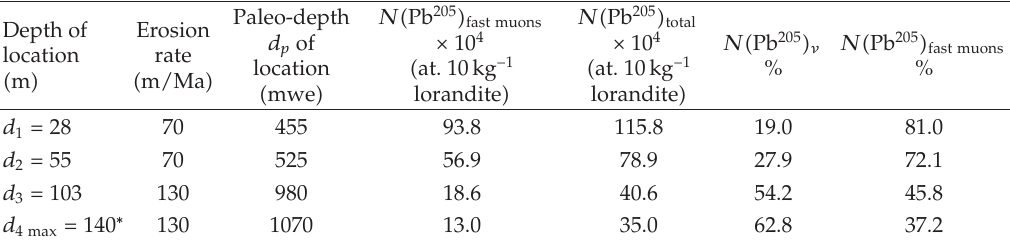
Table 1: Cosmic-ray contributed N μ − and total number N t of 205 Pb atoms per 10kg of lorandite from di ff erent depths, known to contain significant quantities of